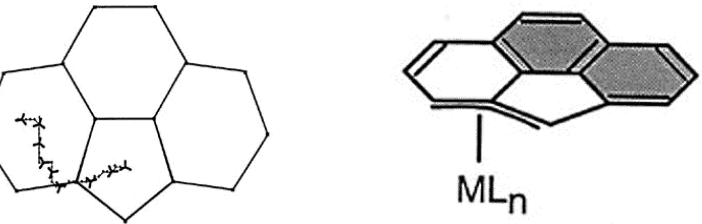
Figure 4. The calculated trajectory of an η 6 to η 5 haptotropic shift taken by an Mn(CO) 3 tripod via an η 3 transition state apparently stabilised by development of aromatic character in the (shaded) naphthalene fragment.